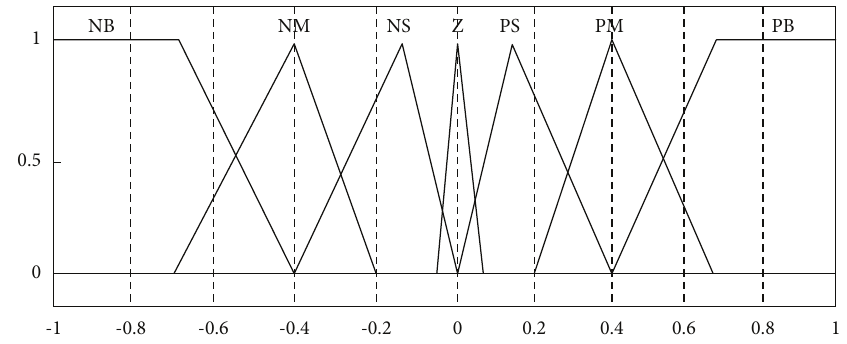
Figure 8: Input d